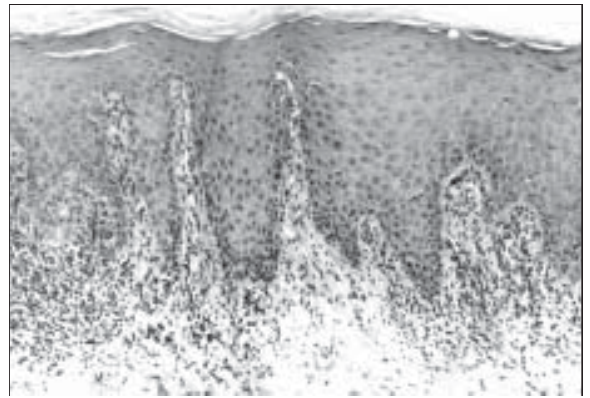
Figura 3 – Líquen plano oral. Orto e paraceratose, acantose moderada, apagamento focal da camada basal pelo infiltrado inflamatório superficial (HE, aumento original